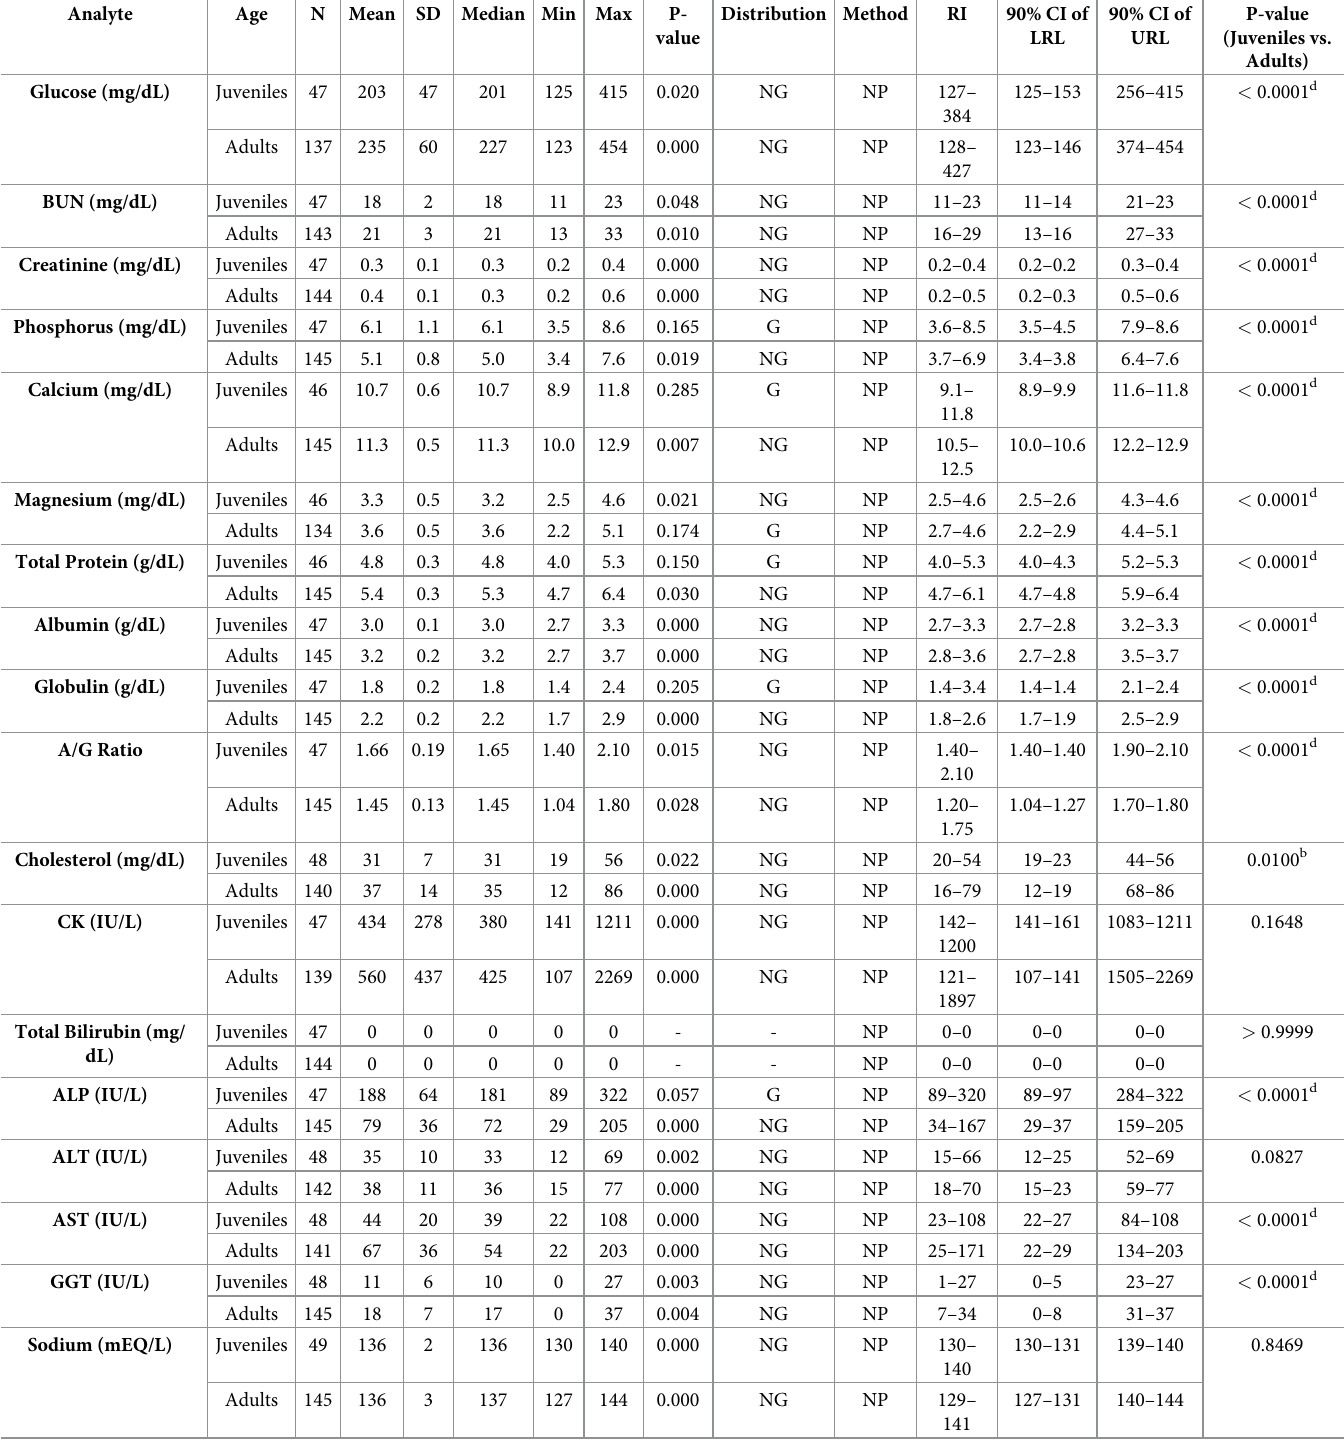
Table 4. Summary data and reference intervals for serum biochemistry parameters of juvenile ( < 5 mo) and adult ( � 5 mo) Hartley guinea